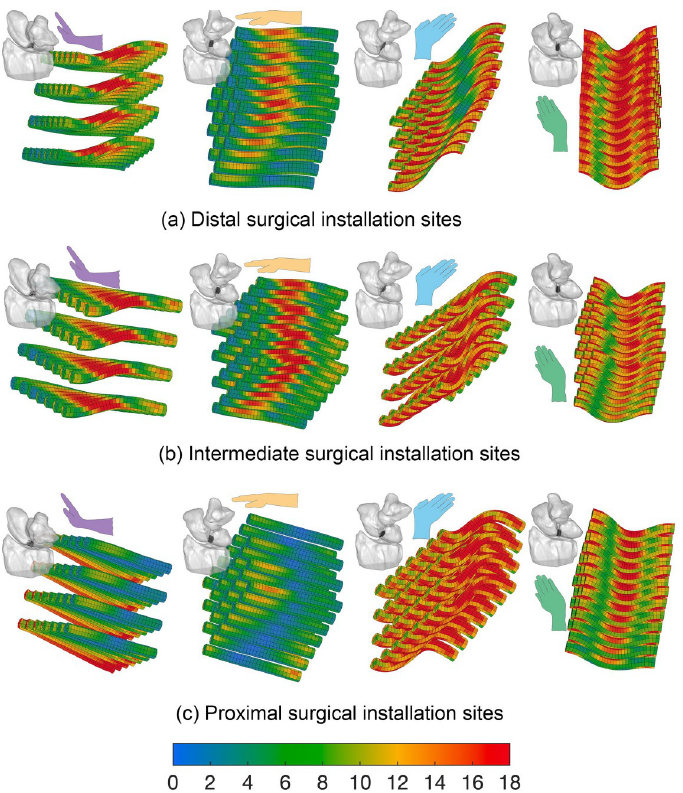
Fig 13. Von Mises stress distribution on the 3 mm ligament-scaffold at three surgical installation sites. (a) The distal (Fig 5b); (b) intermediate (Fig 5c); (c) proximal (Fig 5d) in the dorsal view of the wrist being in positions of extension, neutral, ulnar deviation, and radial deviation. The von Mises stress scale bar is from 1 to 18 MPa.